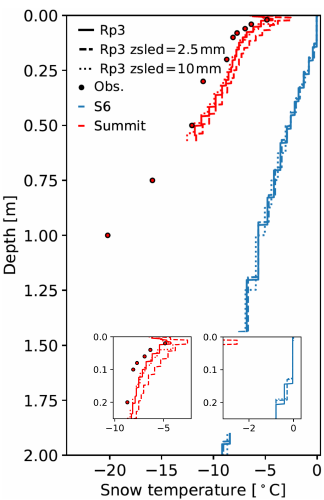
Figure B2. Subsurface temperature profiles for the 20 upper snow layers of Rp3 and Rp3 with z sled = 2 . 5mm, Rp3 with z sled = 10mm, and observations (Obs.) for S6 and Summit for a summer day (10 July 2007) at 15:00UTC. The insets show the results of the upper layers in more